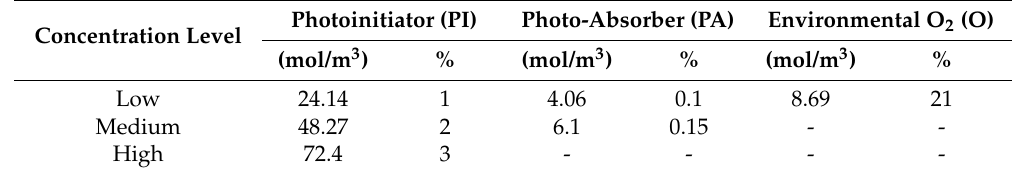
Figure A1. Bridge structure illustration for cure depth measurement. Table A1. Printing parameters for HDDA.